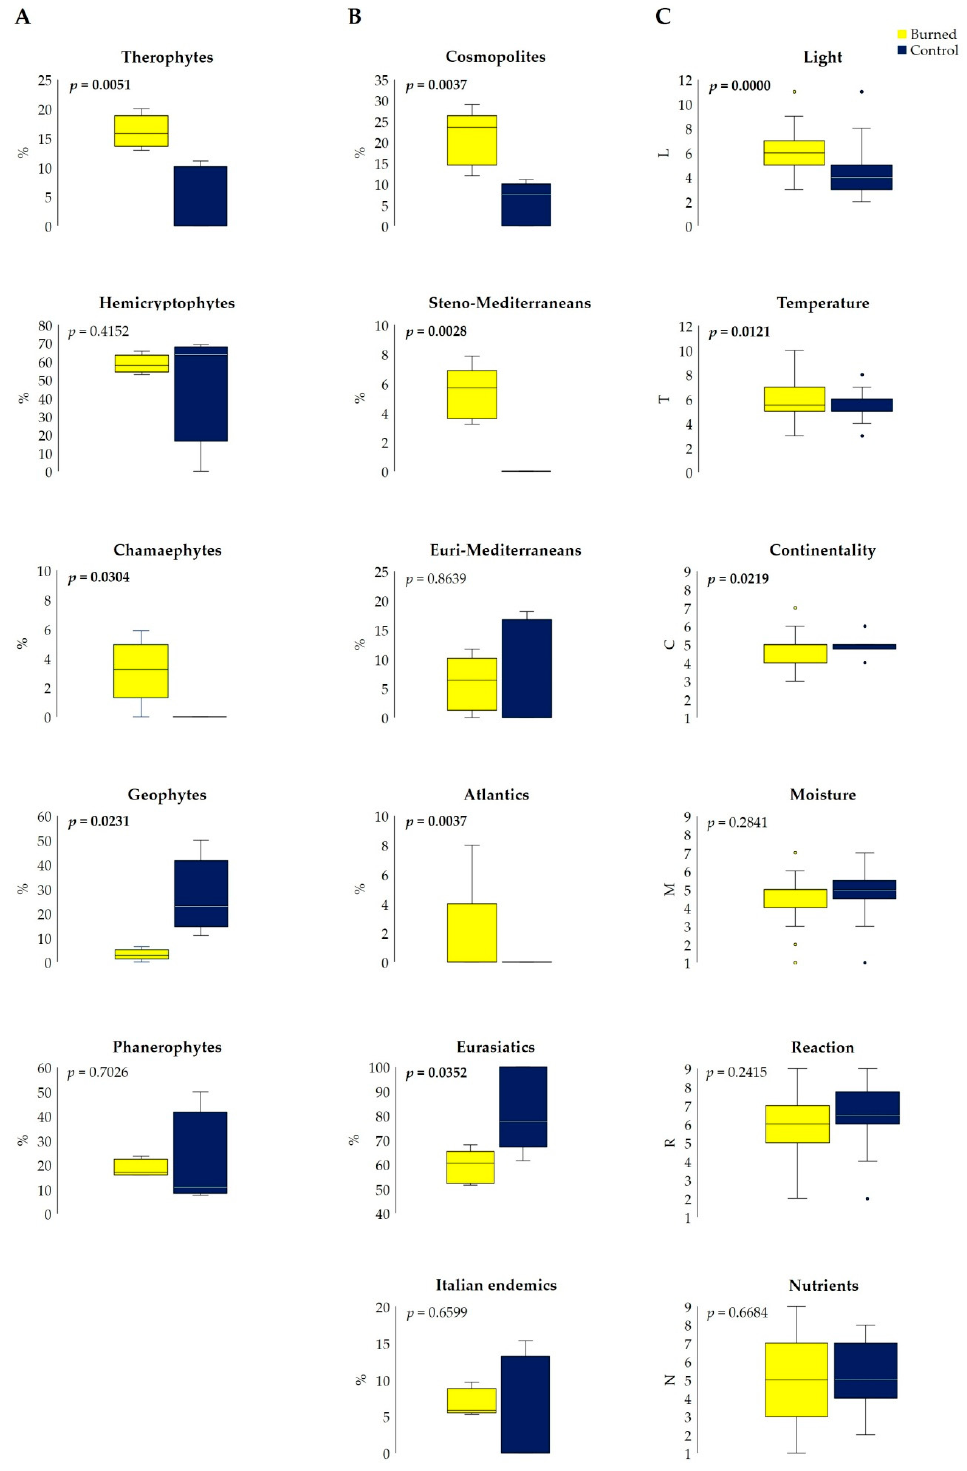
Figure 4. Variations of life-forms ( A ), chorological types ( B ), and Ellenberg Indicator Values ( C ) in burned and control plots (total values; rectangles define 25th and 75th percentiles, horizontal lines show median values, whiskers indicate extreme values, t -test p < 0.05, and raw data are available in Table S3).